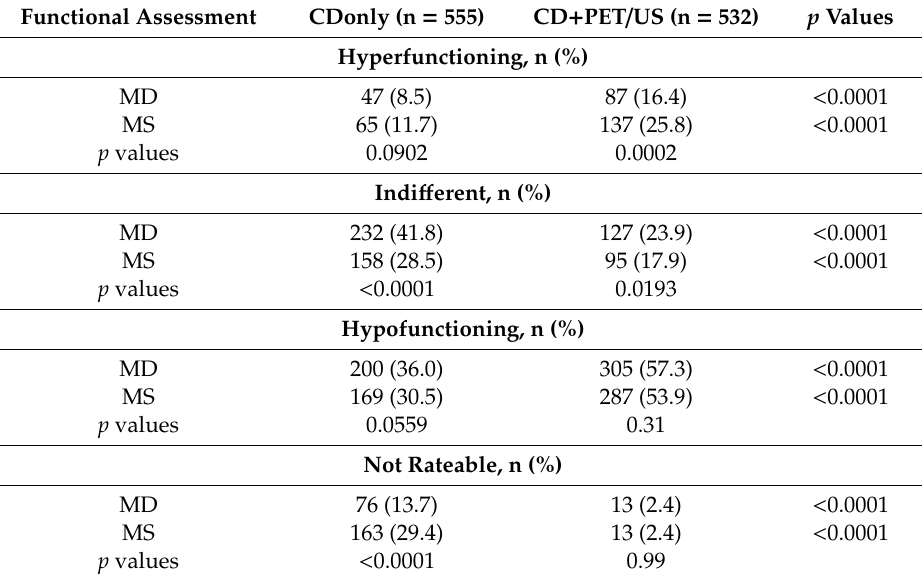
Table 1. Functional assessment of thyroid nodules (TN) in conventional diagnostics (CDonly) versus CD + I-124-PET / US fusion imaging (CD + PET / US); comparison between the ratings of nuclear medicine physicians (medical doctor, MD) and medical students (MS).